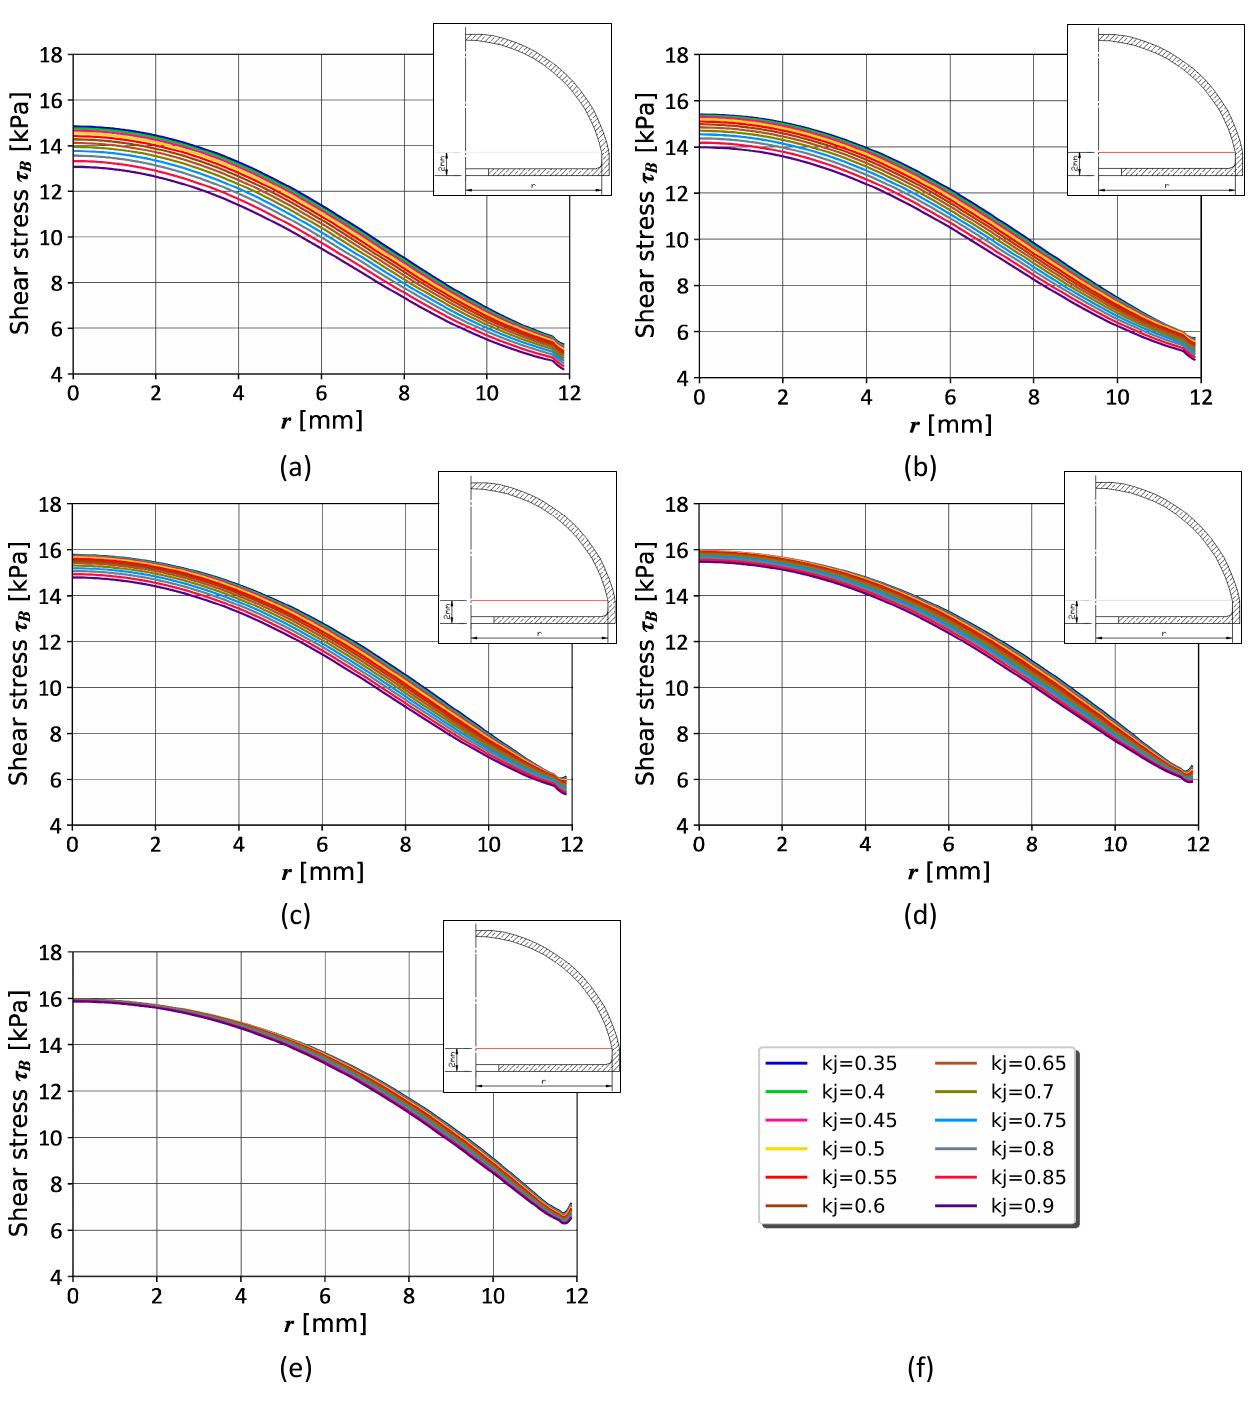
Figure 11. Shear stress τ B distribution for Instance 1 —distance z = 5 mm and thickness gm = 6 mm using different configurations of the kj factor for kpm equal to: ( a ) 0.7; ( b ) 0.75; ( c ) 0.8; ( d ) 0.85; ( e ) 0.9; ( f ) legend.